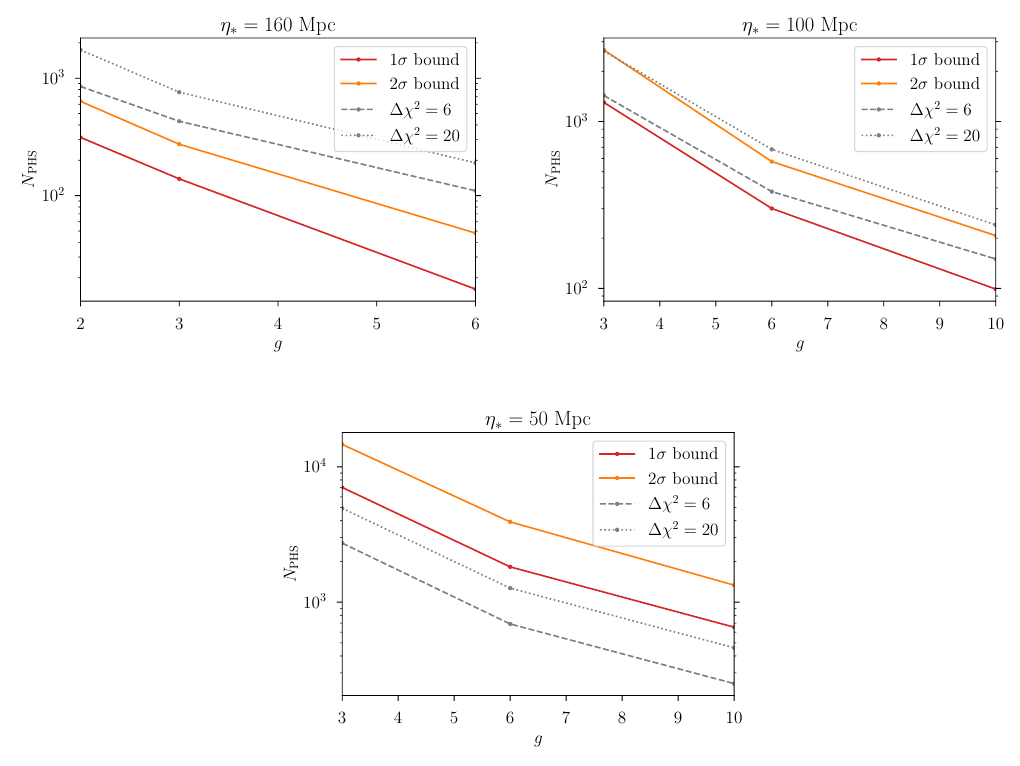
Figure 8 . Upper bounds on the total number of PHS, N PHS in the entire sky with respect to the heavy scalar-inflaton coupling g for (upper-left) η = 160 Mpc, (upper-right) η = 100 Mpc, and ∗ ∗ (lower) η = 50 Mpc. We interpolate the results for different benchmarks for the coupling g . The ∗ 1 σ and 2 σ ( ∆ χ 2 = 6 , 20 ) bounds are obtained using the results in table 1 (table 2). This shows that both for η =160 Mpc and η =100 Mpc, the simple cut-and-count search can perform better ∗ ∗ than a power spectrum